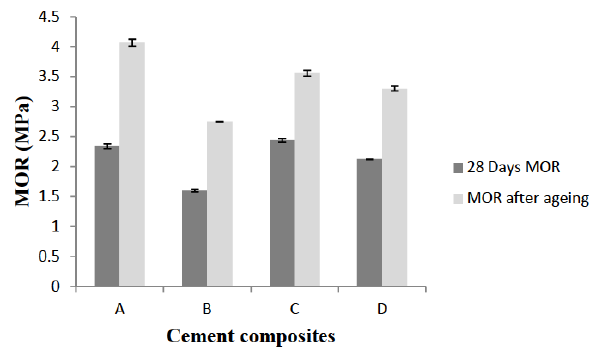
Figure 1: Accelerated ageing effects on MOR